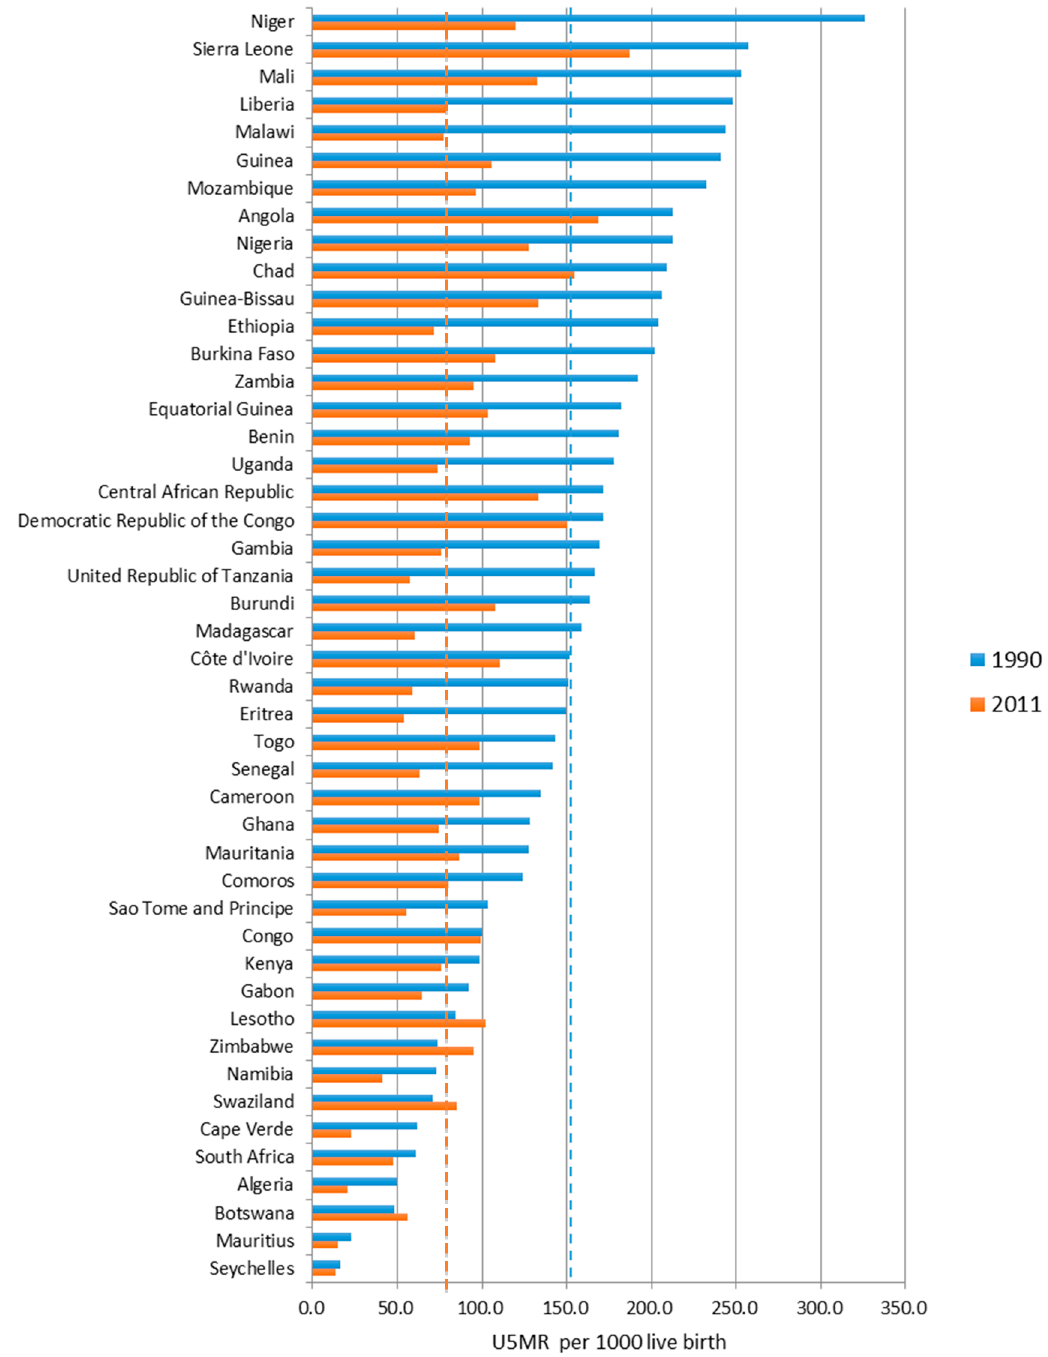
Figure 3. The variation for U5MR of African countries, between 1990 and 2011. (1) In figure, the red dotted line is the average value for 2011, 87.54 per 1000 liver birth, while the blue dotted line represent the average value for 1990, 151.97 per 1000 liver birth; (2) The countries were sorted by U5MR for 1990.